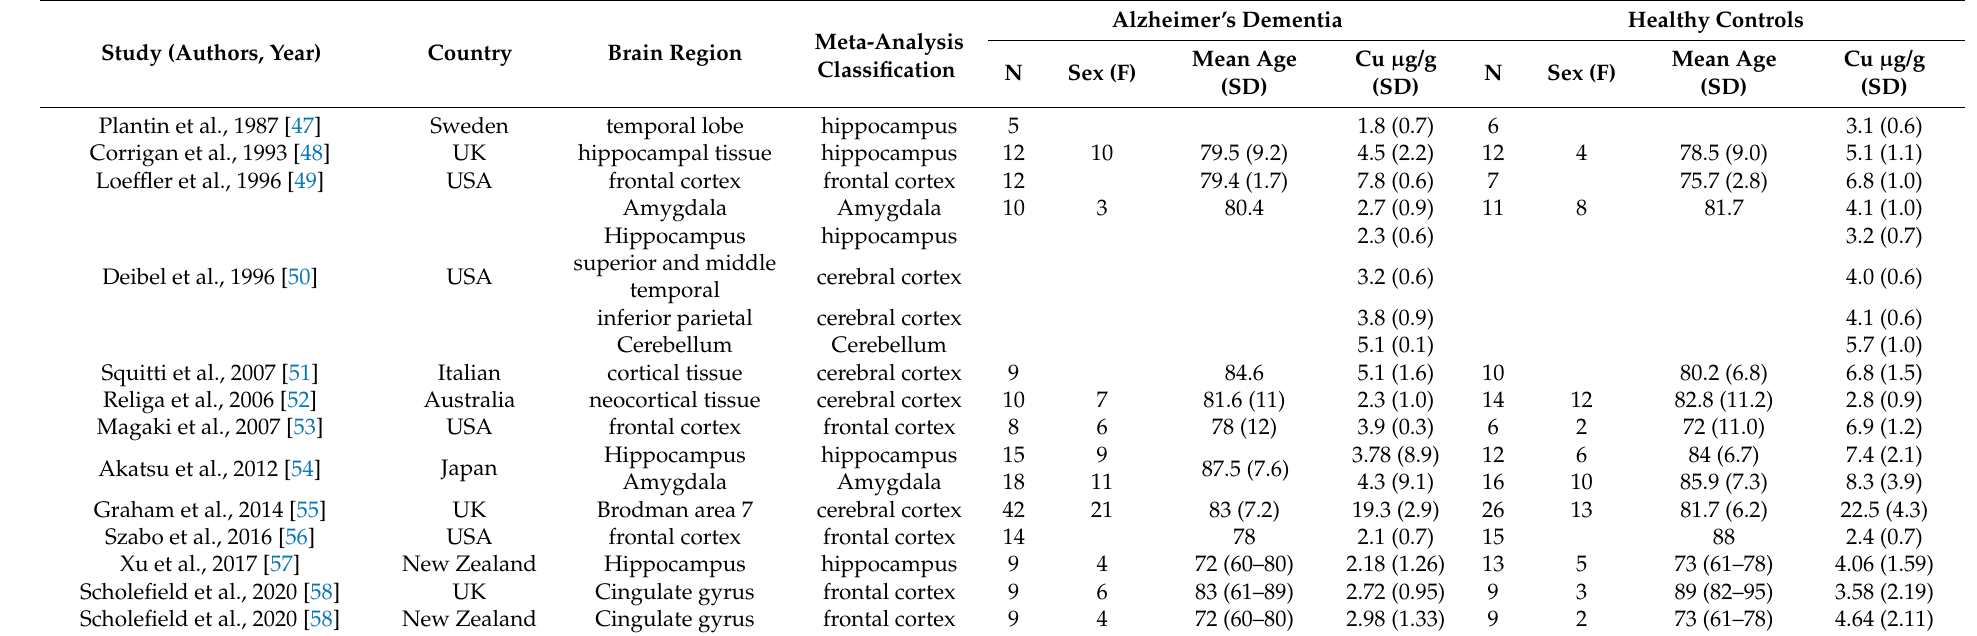
Table 1. Studies included in the meta-analysis of brain Cu in Alzheimer’s